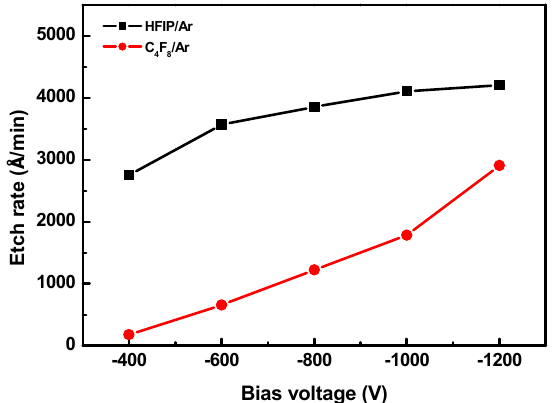
Figure 3. Change in the SiO 2 etch rates with the bias voltage in HFIP/Ar and C 4 F 8 /Ar plasmas. Higher etch rates in HFIP/Ar plasmas compared with in C 4 F 8 /Ar plasmas can